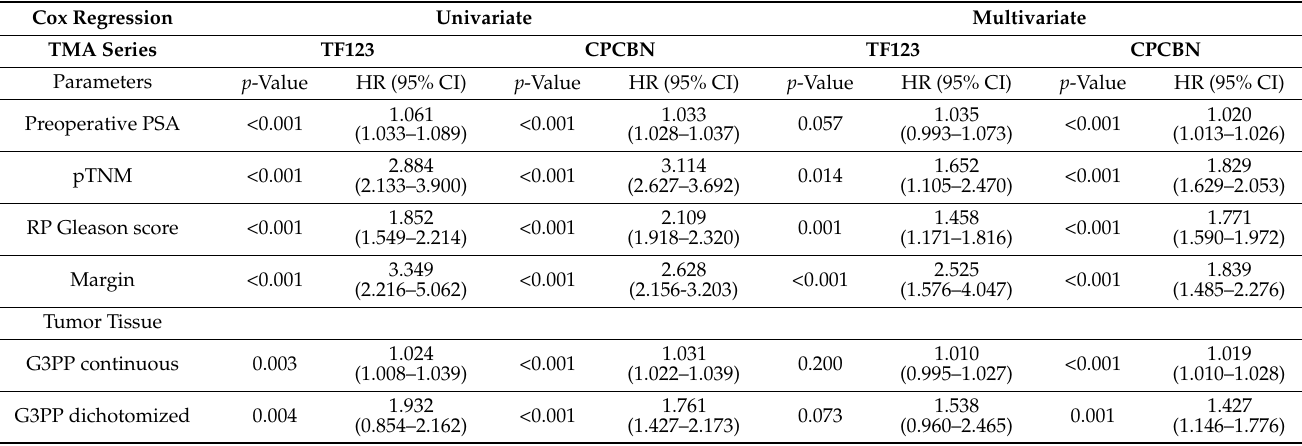
Table 2. Univariate and multivariate Cox regression analyses predicting biochemical recurrence (BCR) in the TF123 and CPCBN cohort TMAs after 5-year